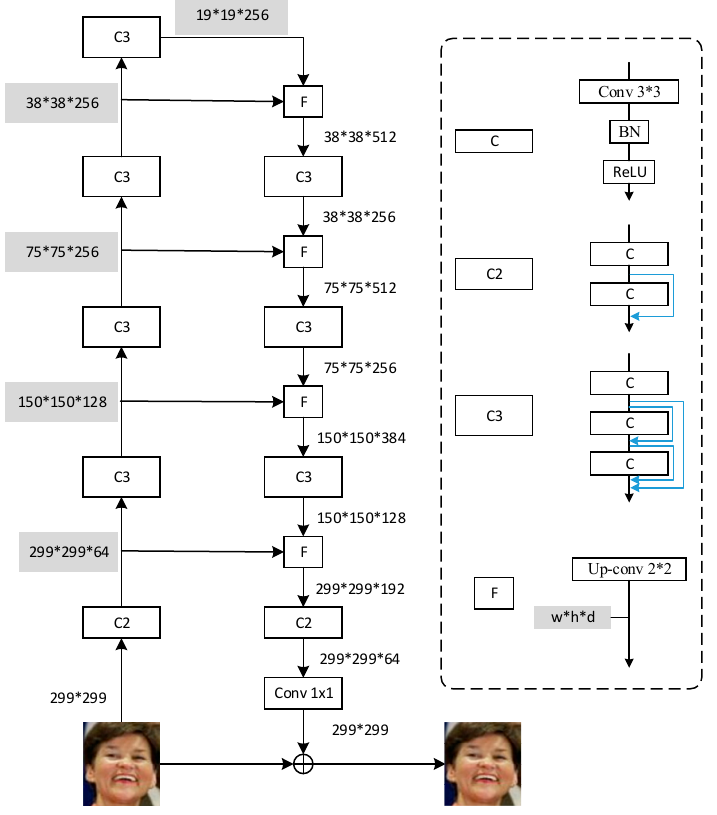
Figure 3. Deep denoising neural network (UDDN) network structure. The structure consists of an encoder and a decoder. The output of the decoder is added to the adversarial images to obtain the denoised image. The whole model is composed of C2, C3, and F units, the structures of which are shown on the right side of the